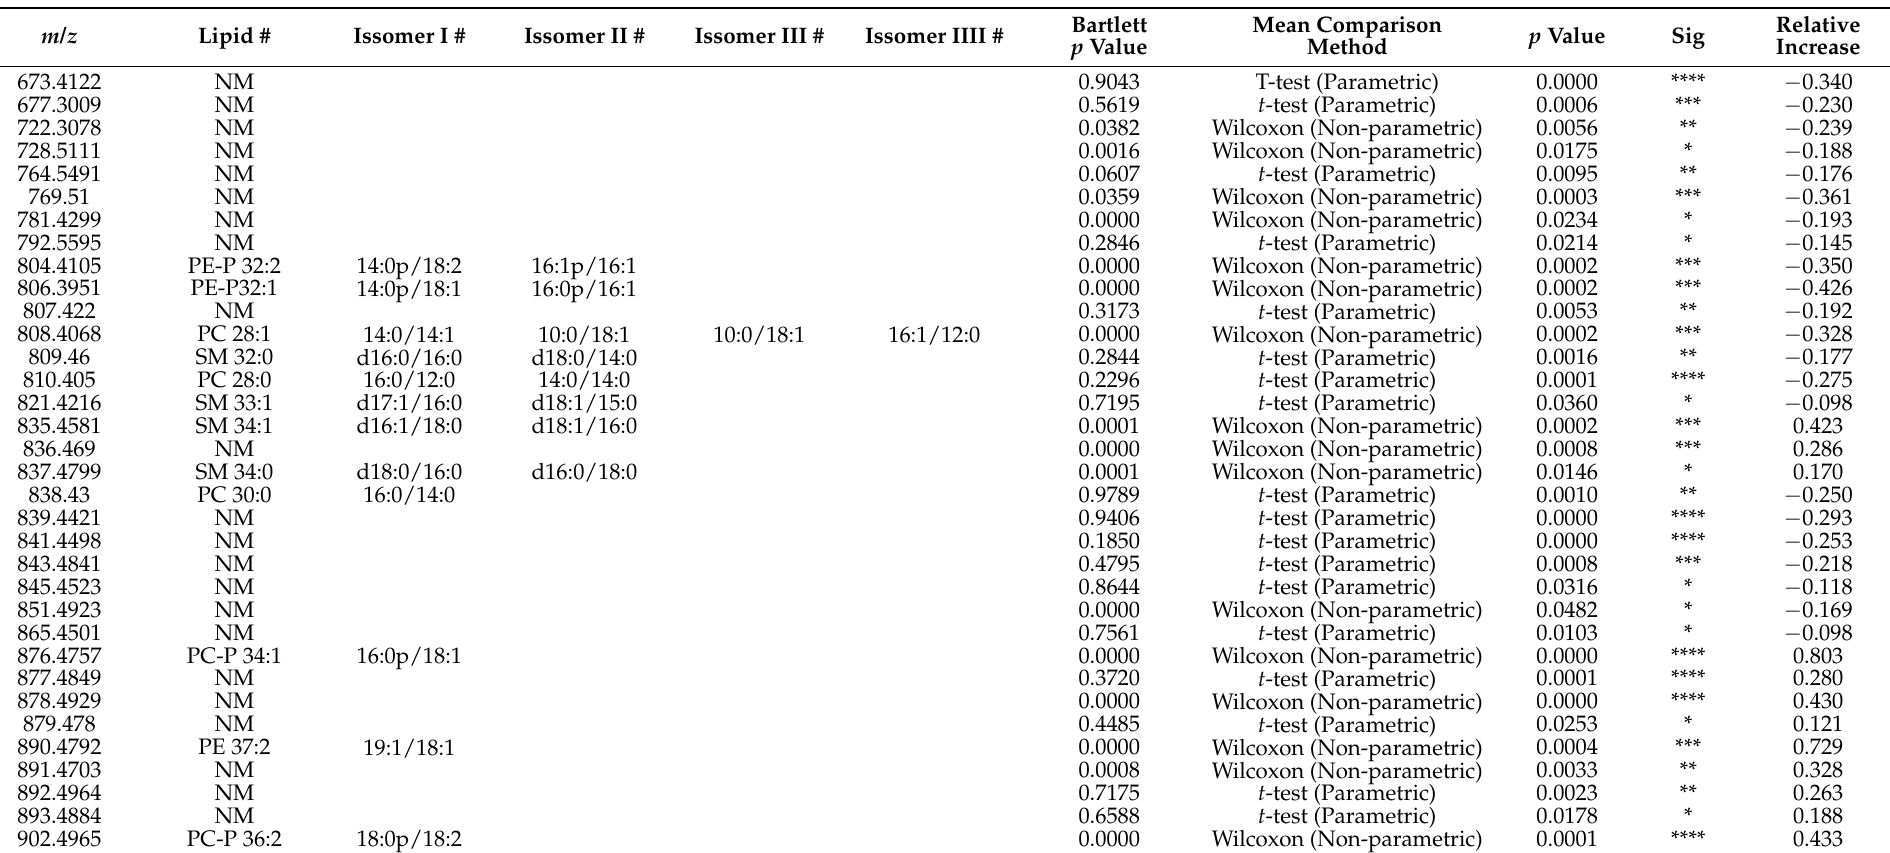
Table A4. Mass channels showing significant differences between negative and positive values for haptoglobin. The relative magnification is (intensity (+) − intensity (-))/intensity (-). The species found in this table are ionized with